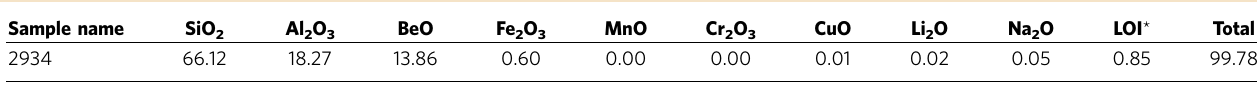
Table 1 | Chemical composition (in wt%) of the investigated beryl crystal.